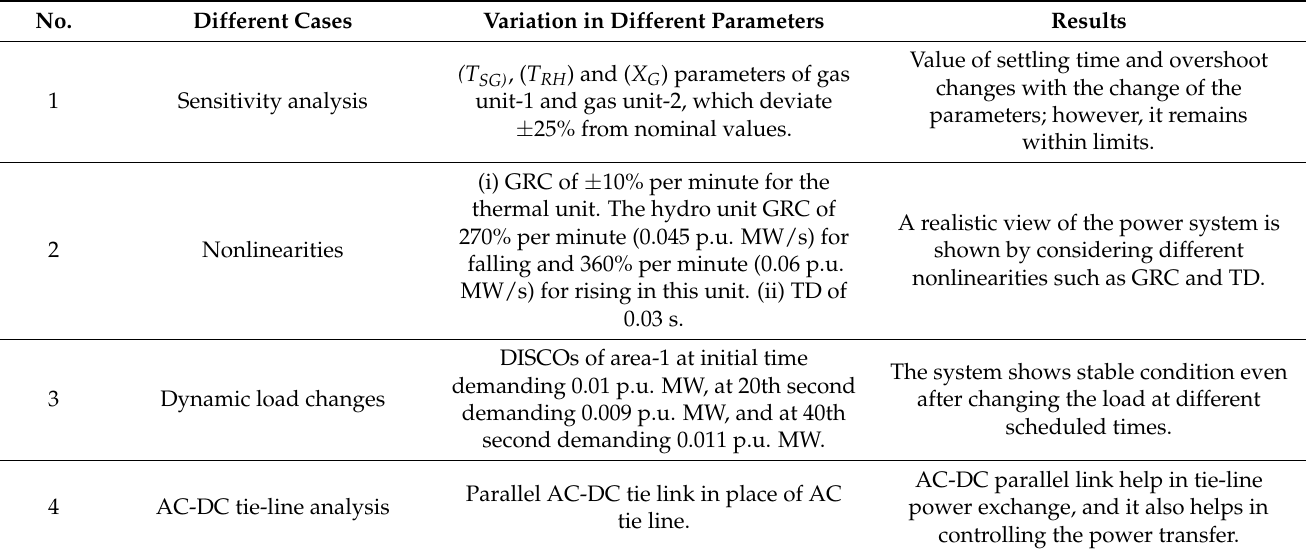
Table 10. Summary results for different cases related to uncertainties and dynamic changes.